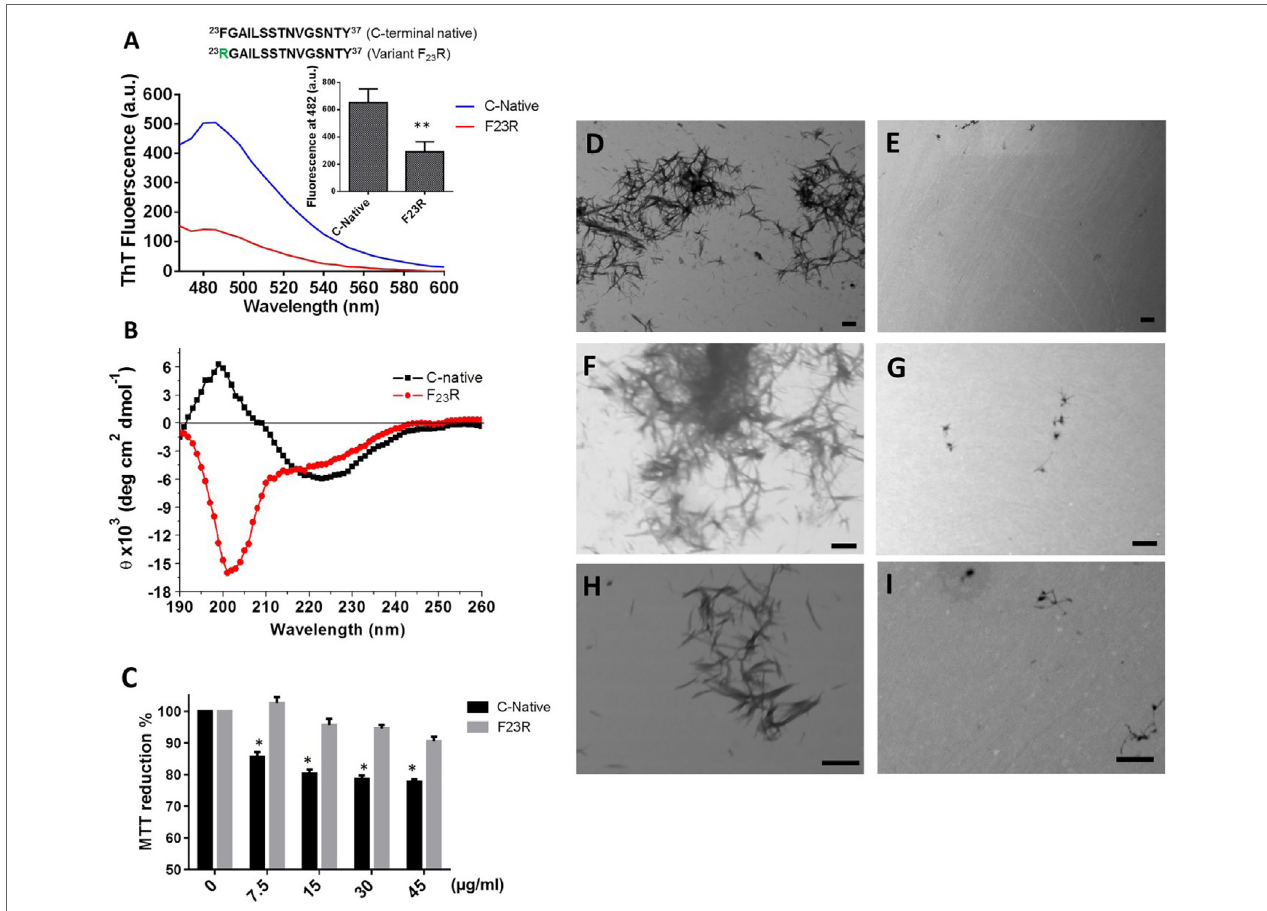
FigUre 3 | The F 23 R variant modulates beta-sheet formation in C-terminal 23–37 islet amyloid polypeptide domain. (a) Emission values obtained with ThT- fluorescence assay, the peak was recorded at 482 nm. (B) Circular dichroism spectra of the variants. (c) Cell viability evaluated through MTT assay in RIN-m5F cells under increasing concentrations of peptides. Mean values were presented ( n = 6, X ± SD) * p < 0.001, ** p < 0.005. Peptide samples processed by transmission electron microscopy of C-terminal (D,F,h) and F 23 R variant (e,g,i) . Bars correspond to 500